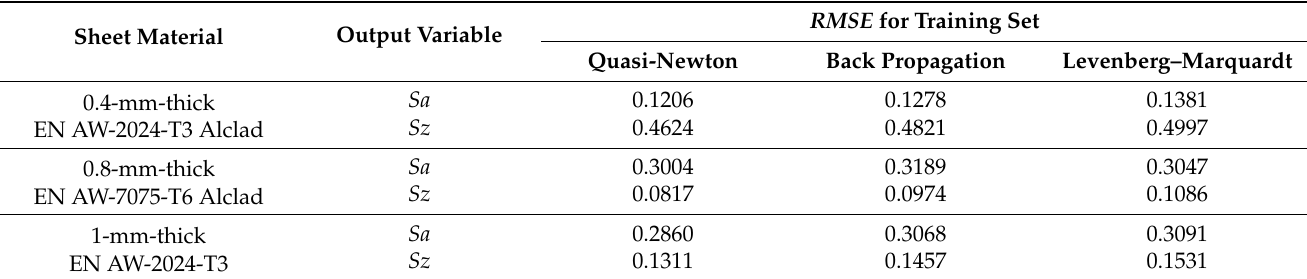
Table 6. RMSE s for the 2:2-8-1:1 networks trained using different